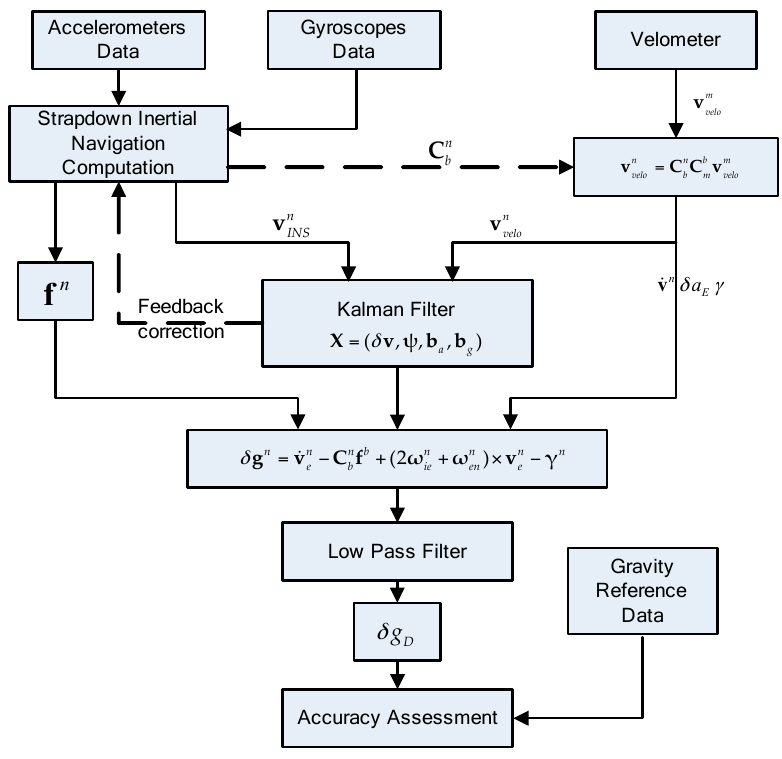
-frame; ( b ) -frame. n n